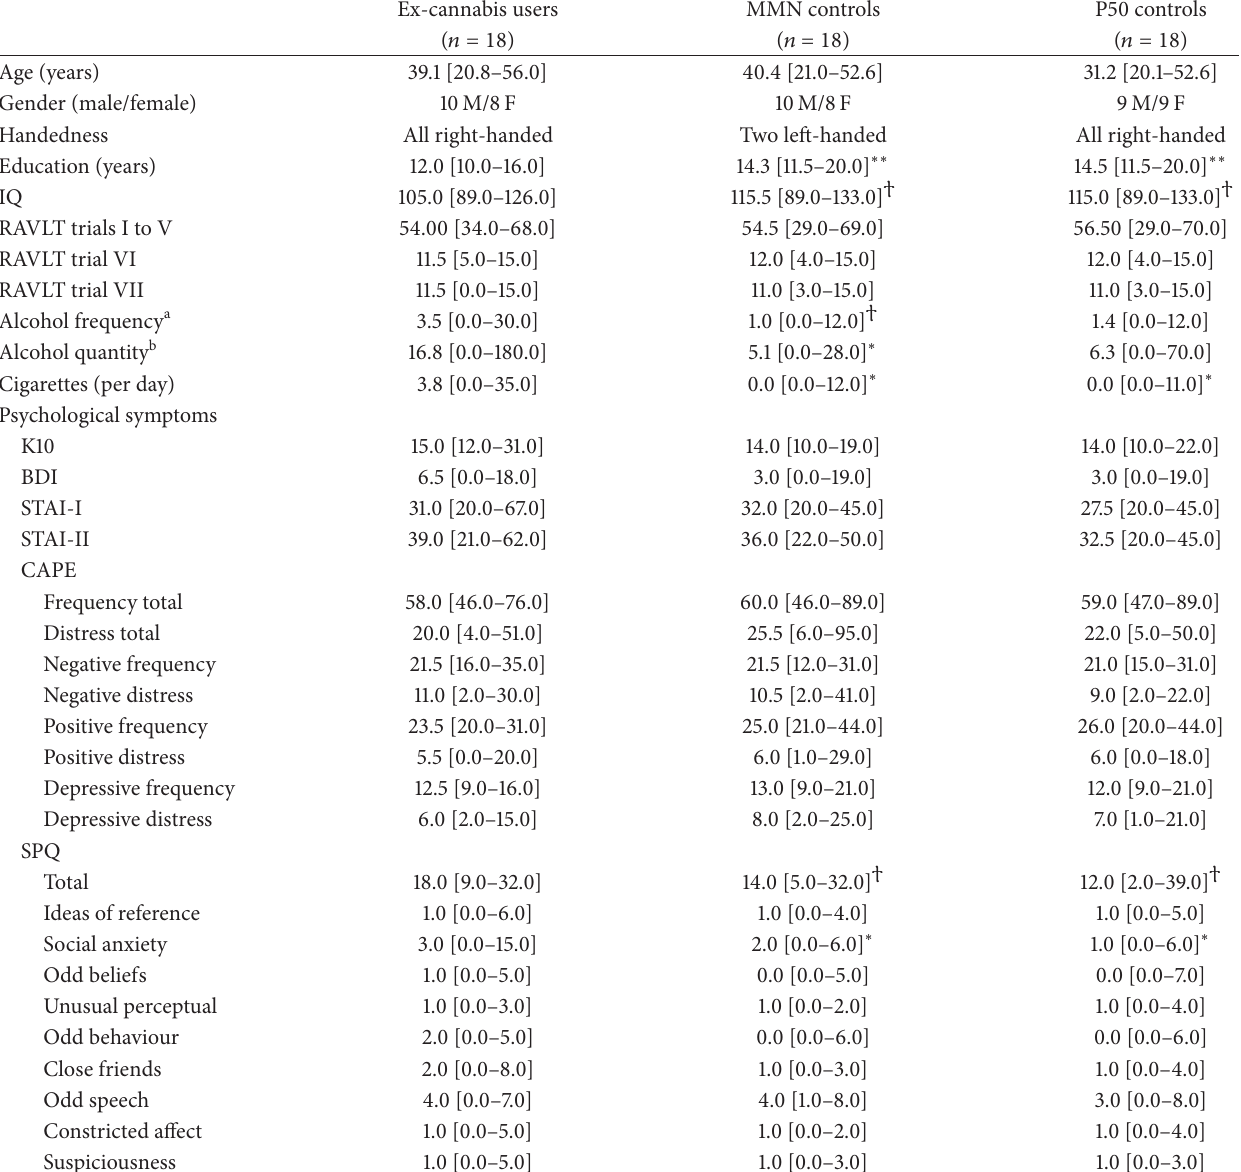
Table 2: Demographic, cognitive, and psychological symptom measures in ex-cannabis users and healthy nonuser controls for MMN and P50